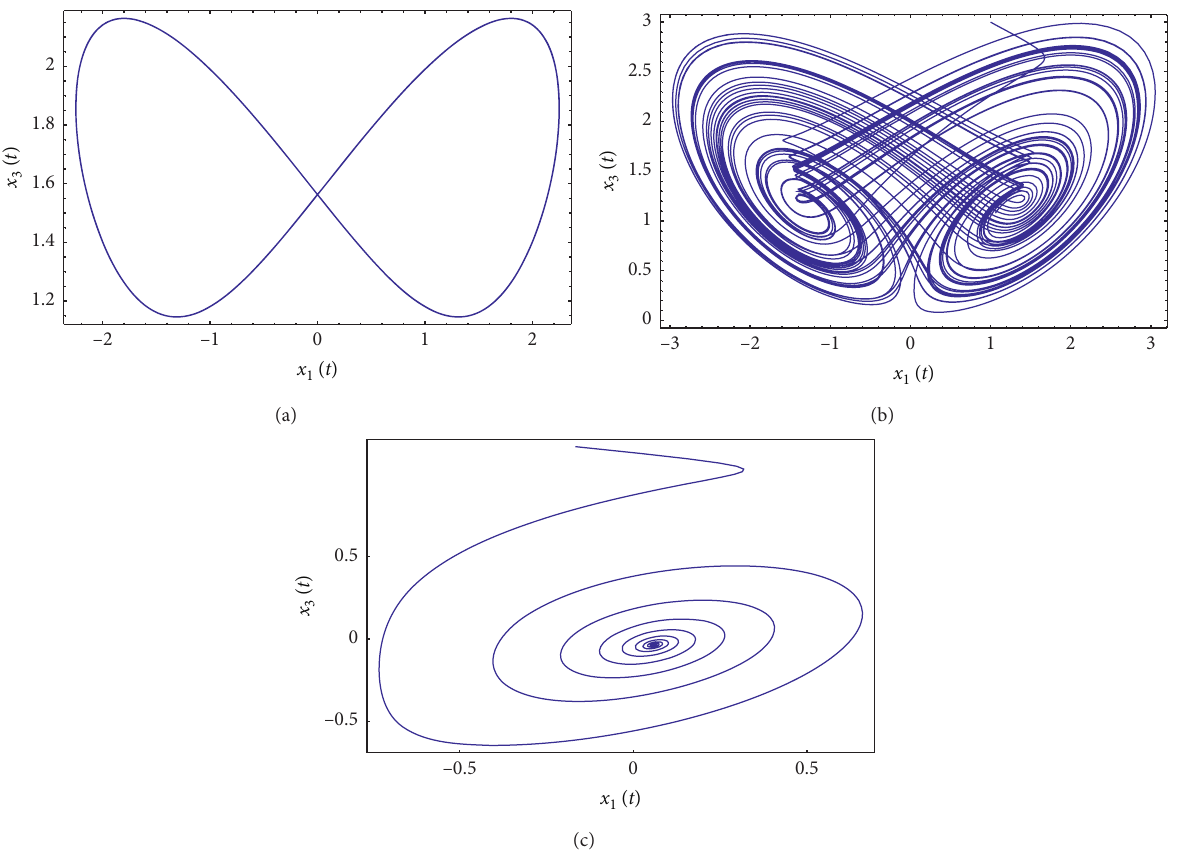
Figure 3: With the same initial conditions in Figure 1. (a) Periodic solution in ( x ( t ) ,x ( t )) plan, a ( x 1 3